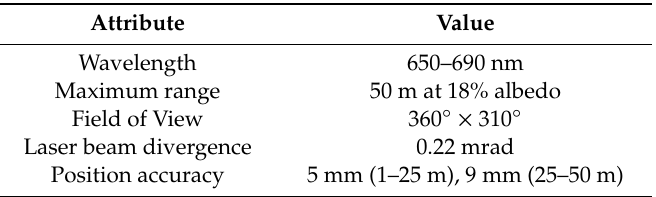
Table 1. Main parameters of the Z&F / Leica